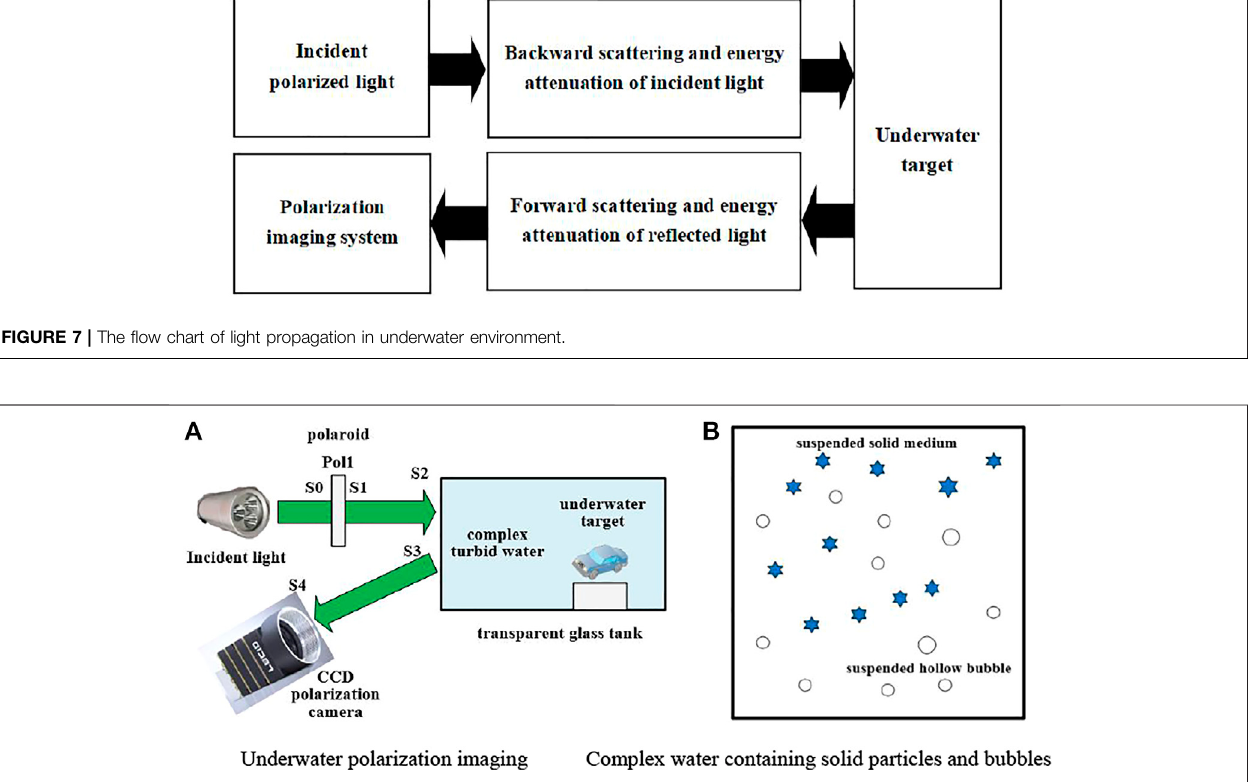
According to Figure 8 , the underwater target polarization